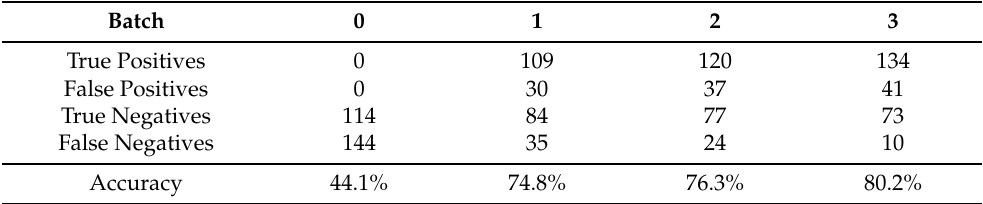
Table 2. Classifier’s accuracy without hyperparameters’ optimisation over training batches using Sigmoid activation function on the original federated learning architecture of [27].